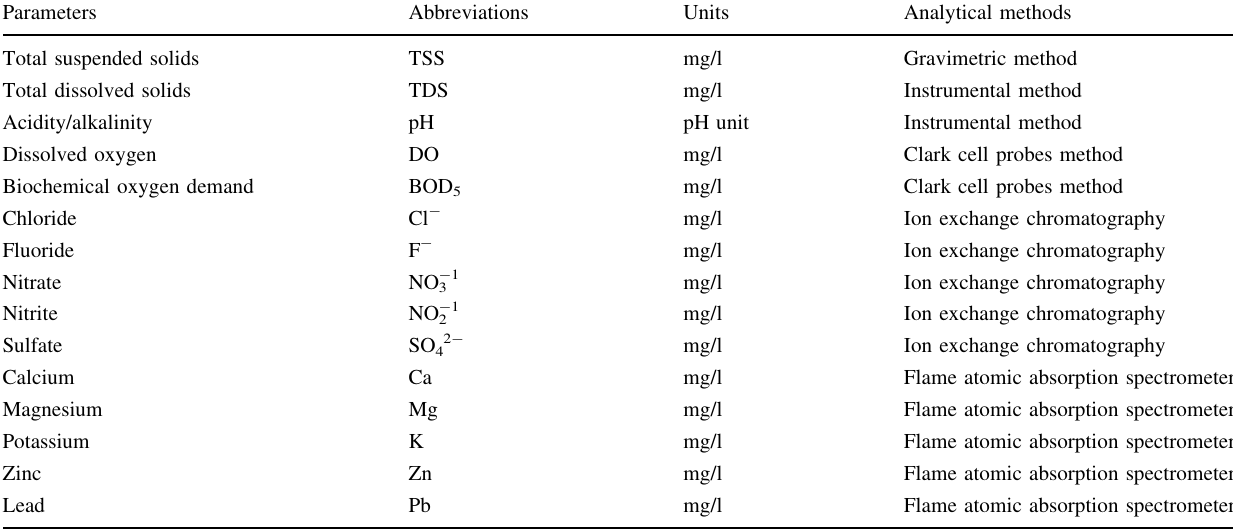
Table 1 Water quality parameters associated with their abbreviations, units and analytical methods